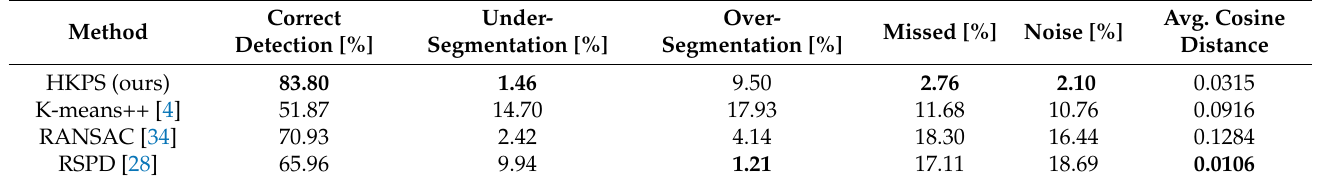
Table 2. Average result of with-noise Virtual KITTI Dataset. Best results are highlighted in